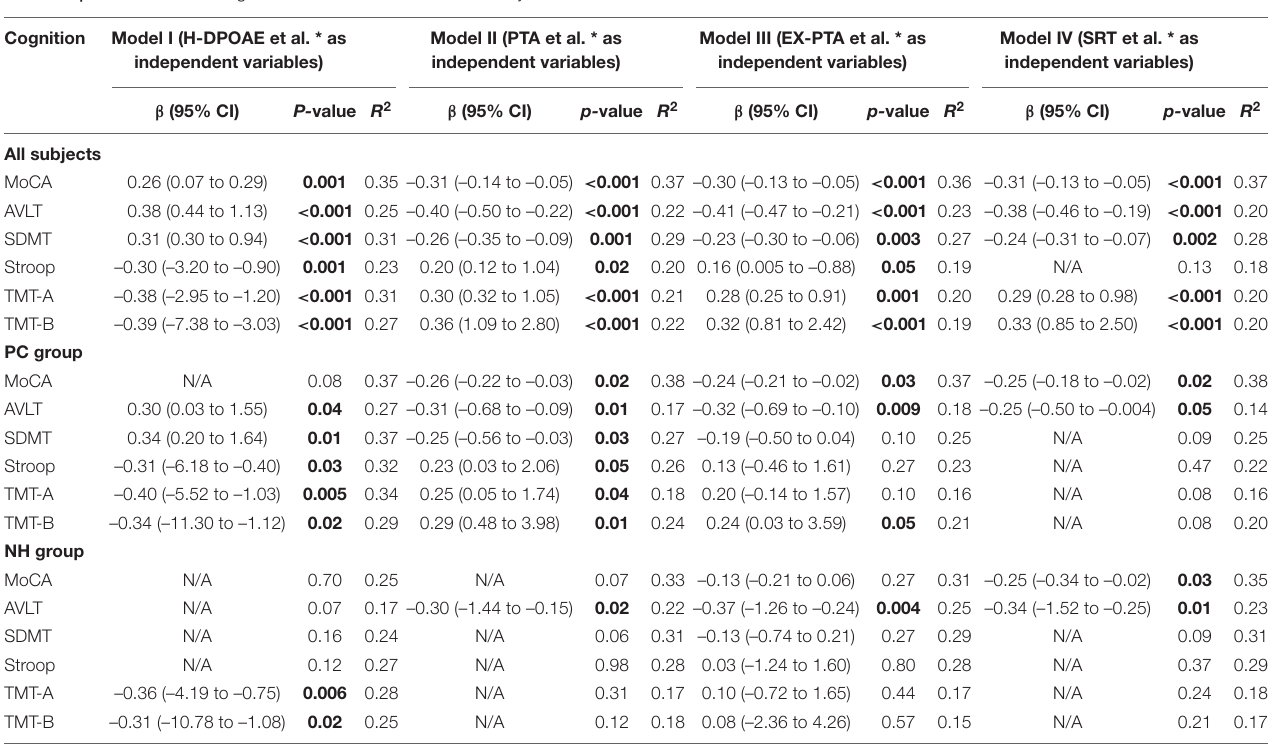
TABLE 5 | Multivariate linear regression models with different auditory variables. Cognition Model I (H-DPOAE et al. * as Model II (PTA et al. * as independent variables) independent